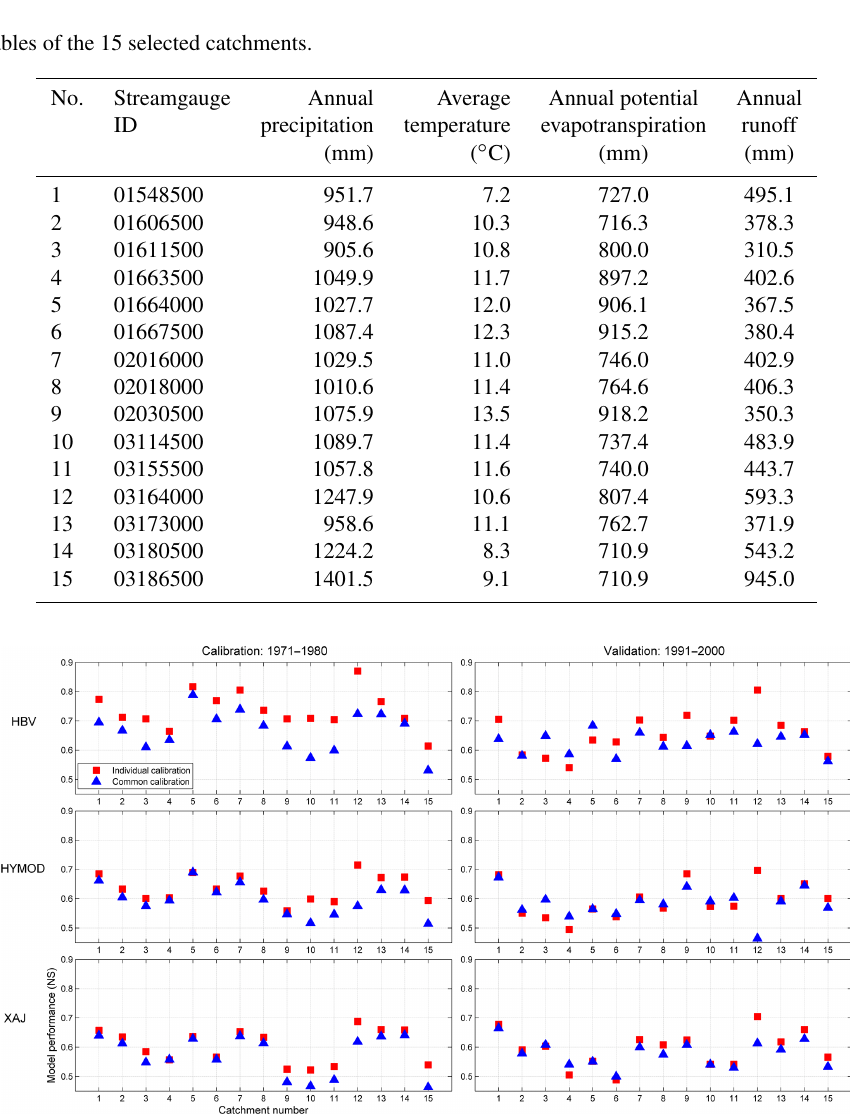
catchments, while others have parameters which are hardly